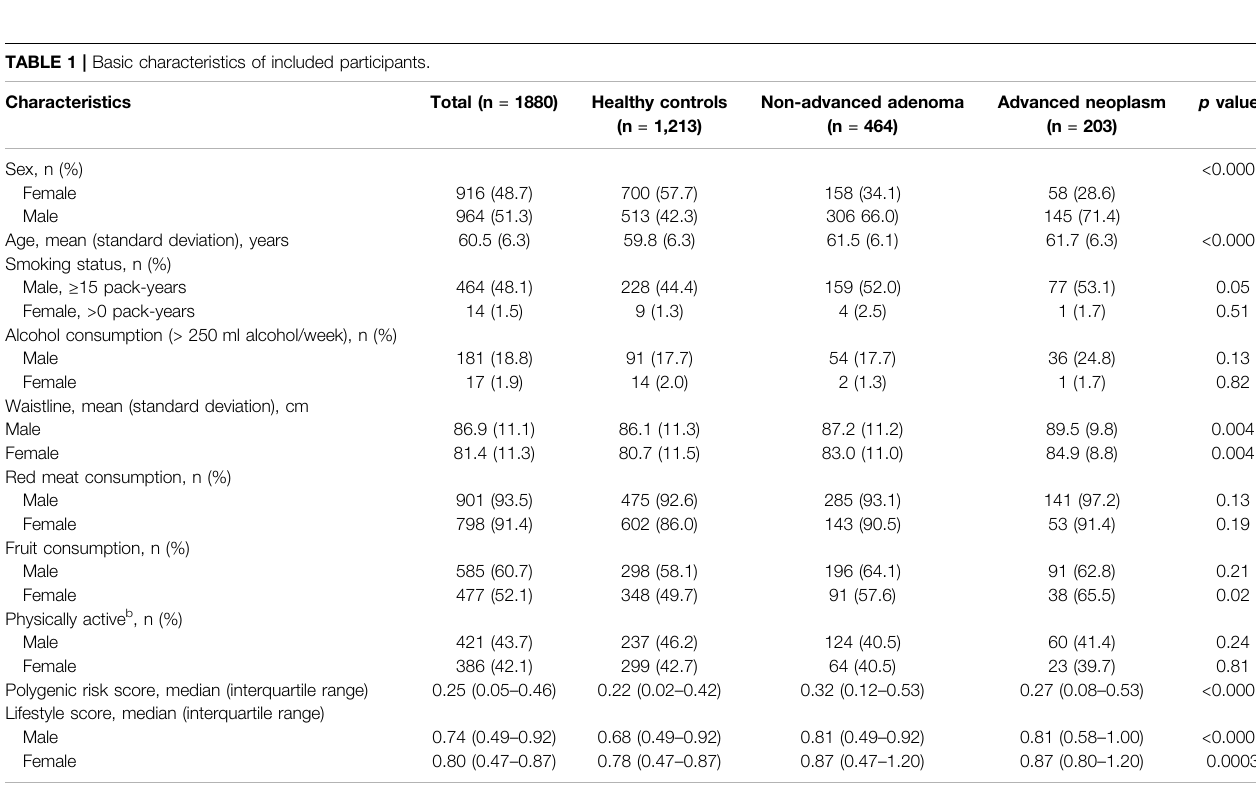
TABLE 1 | Basic characteristics of included